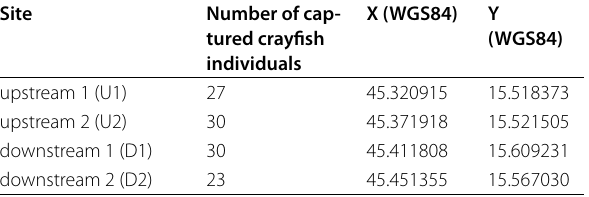
Table 1 Number of collected crayfish individuals and geographical coordinates of sampling sites along the invasion range of the signal crayfish in the Korana River in 2018